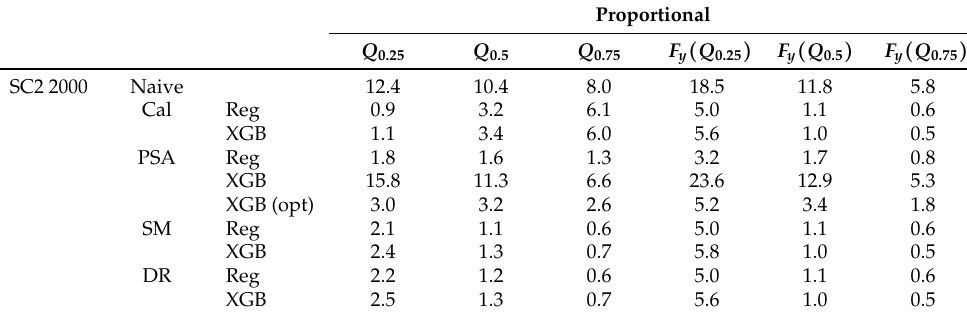
Table 4. RMSE (%) including hyperparameter optimization when